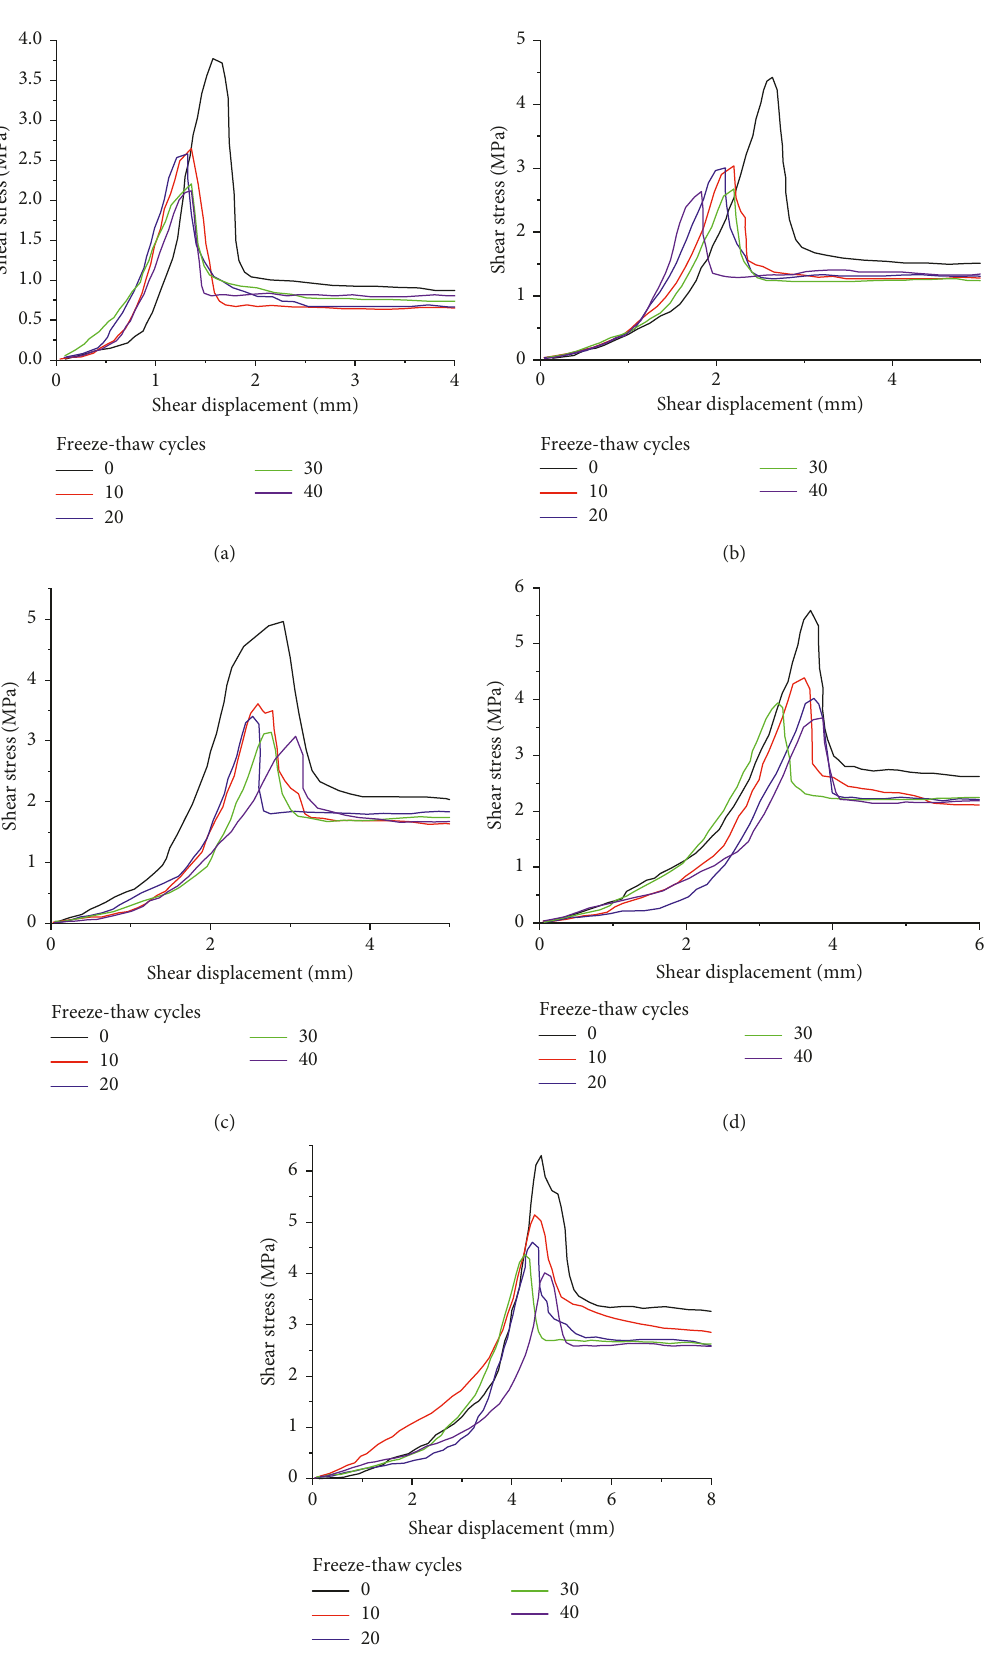
Figure 8: Relationship between shear stress and shear displacement of specimens with different freezing-thawing cycles under normal stress. Normal stress (a) 0.5MPa, (b) 1.0MPa, (c) 1.5 MPa, (d) 2.0 MPa, and (e) 2.5